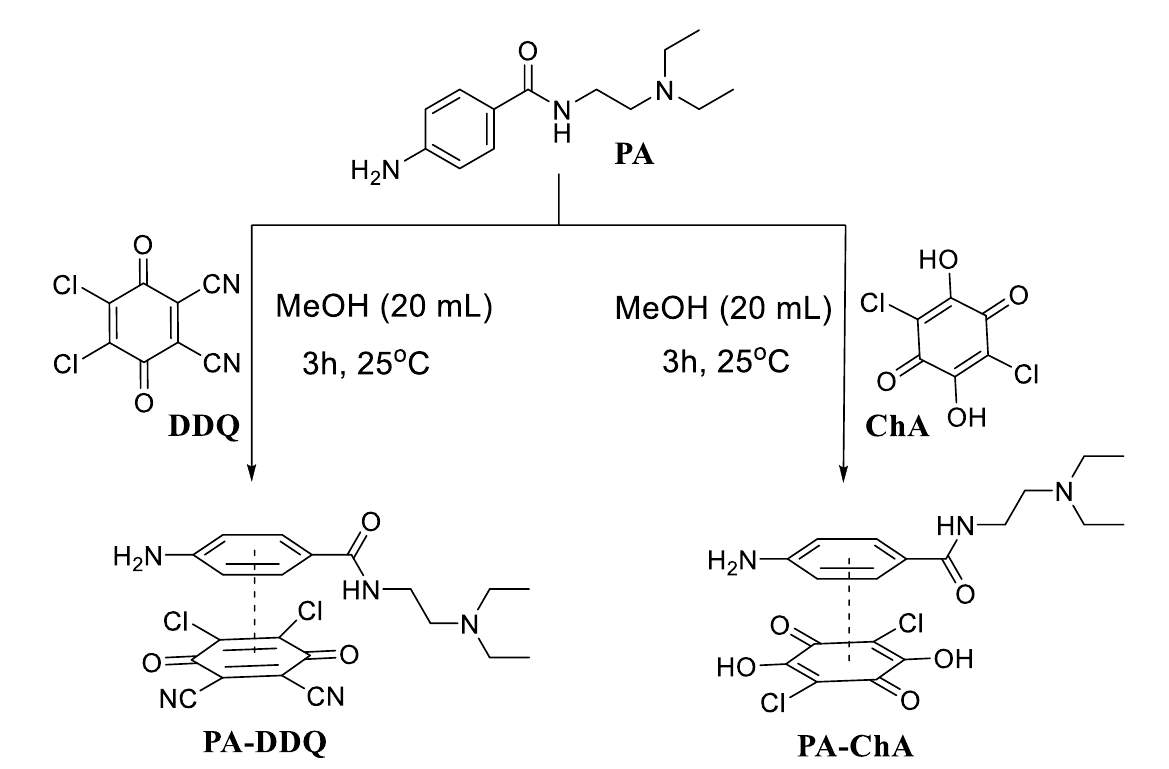
Figure 2. Absorption curve of CT complex: ( A ) absorption maximum of PA, ChA, and DDQ; ( B ) absorption maximum of PA-ChA and PA-DDQ complexes; and ( C ) expanded spectra shown at 400–650 nm for PA-ChA and PA-DDQ complexes (all spectra were taken in acetonitrile).